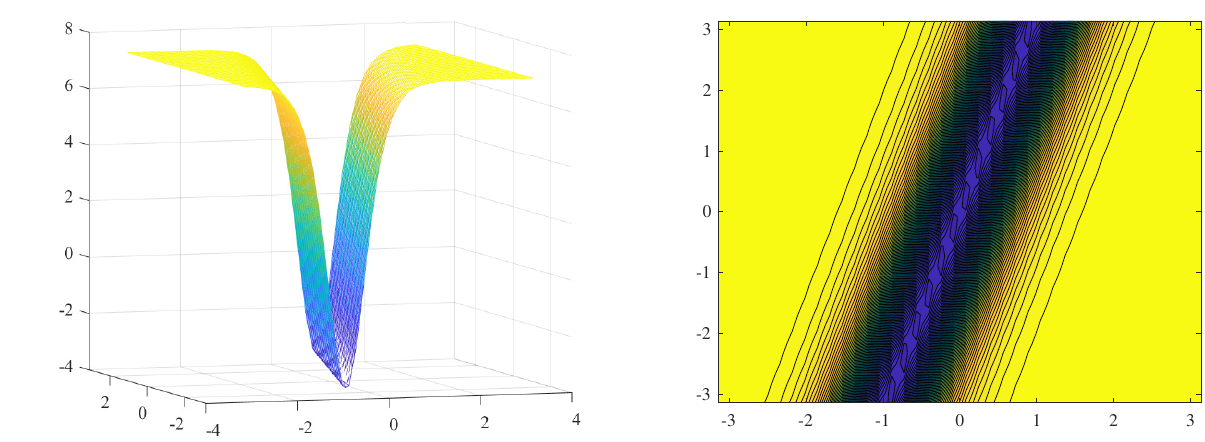
Figure 5. A traveling wave solution and its contour for the solution W 61 ( ξ ) under the values a 1 = a 3 = 0, a 2 = 2, a 4 = − 1, α = β = m = 1 inside the domain − π ≤ x , t ≤ π